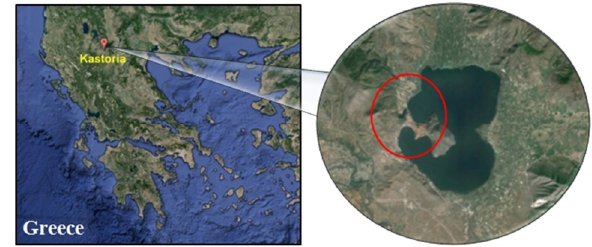
Figure 1. The location of the Regional Unit of Kastoria in Greece (left image) and the city of Kastoria in the red circle (right image) (Karagianni, 2019).